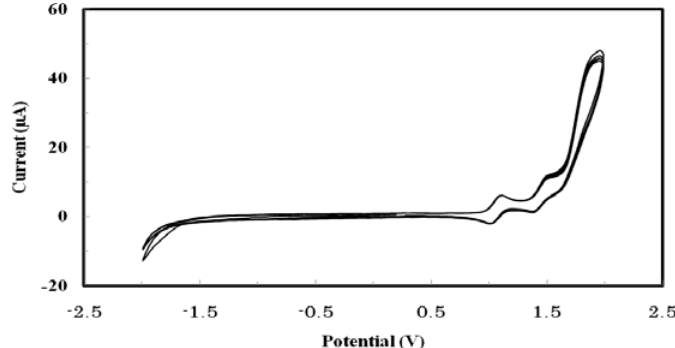
Figure 4. Cyclic voltammogram of THTP-C vs. Ag/AgCl